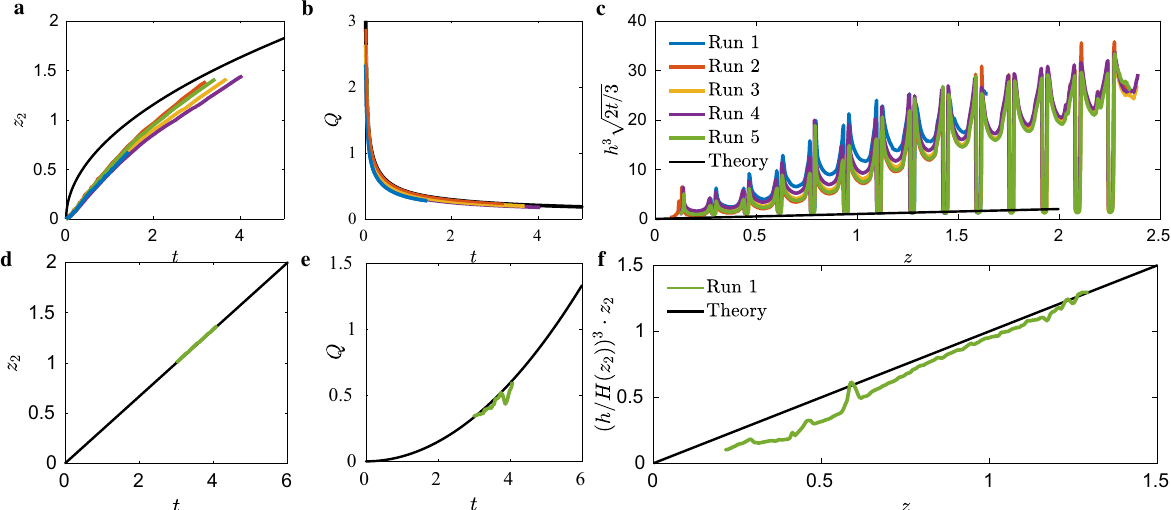
Fig. 10 ICF-8 and -9 data. Single drain data for ICF-8 and -9 cells. a – c : ICF-8 drain data. a Bulk advancing front z 2 , b volumetric fl ow rate Q plotted against time, and c self-similar time-averaged interfacial height h 3 (2 t /3) 1/2 , each overlaid with analytic solutions (black) from Eqs. (5), (6), and (7), respectively. d – f : ICF-9 drain data in the linearly tapered section. d Bulk advancing front location z 2 ( t ) and e volumetric fl ow rate Q ( t ), and f the self-similar time-averaged interfacial height with the respective analytic solutions of Eqs. (10), (9), and (8)